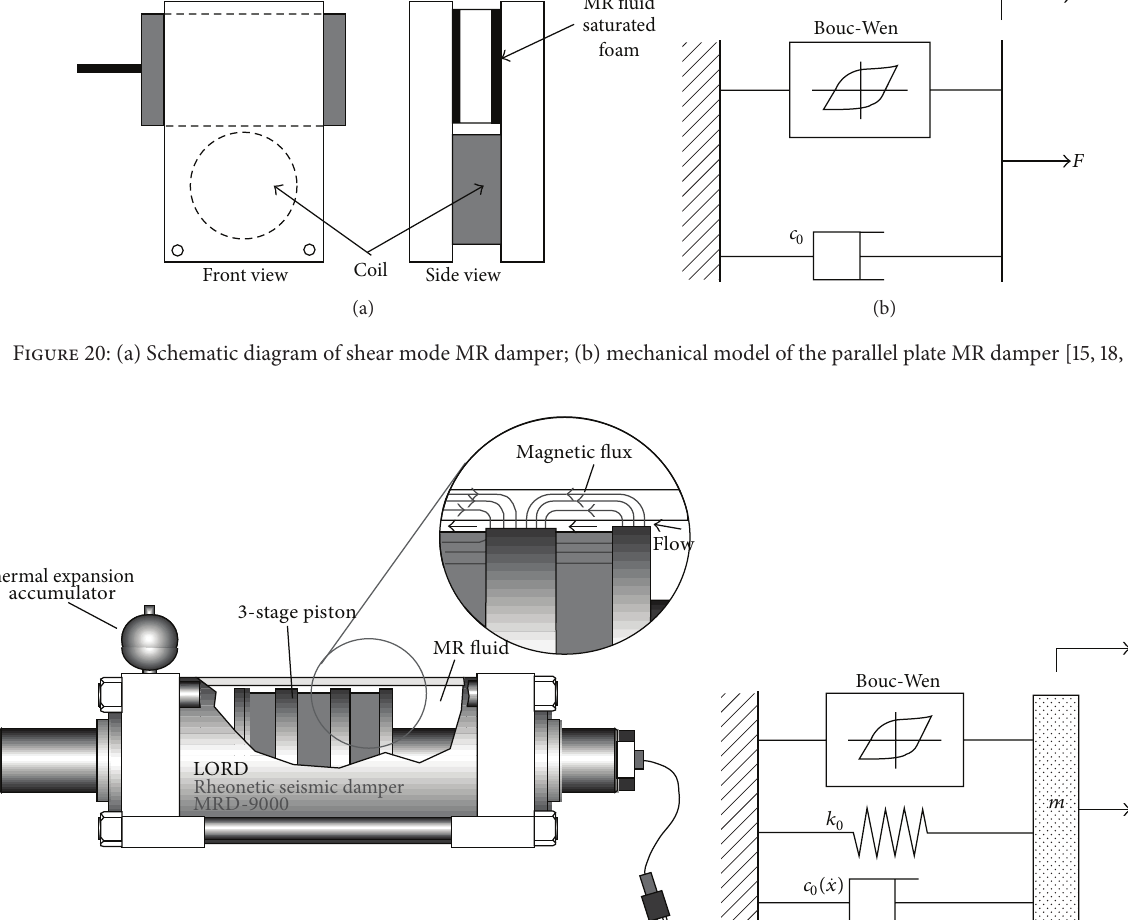
modifications. Section 3 presented different approaches used for the identification of the Bouc-Wen model